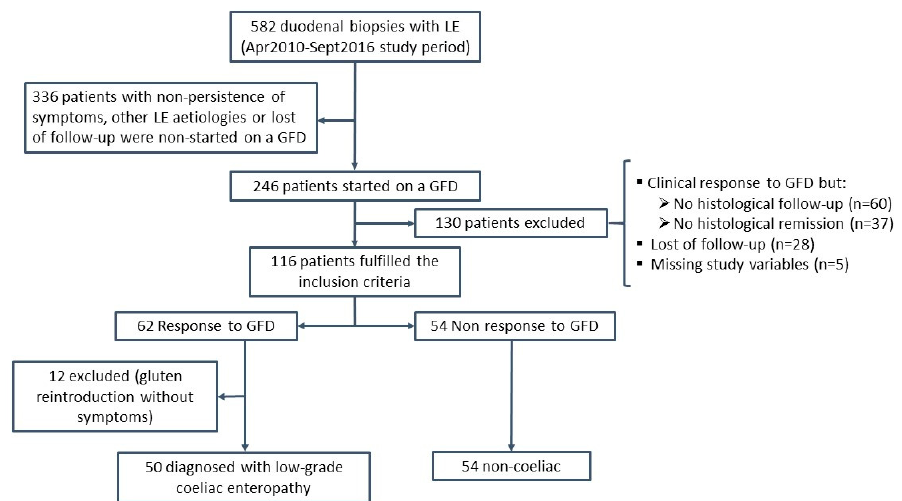
Figure 1. Flow diagram of the participants throughout the study. LE: lymphocytic enteritis (IEL count > 19%); GFD: gluten-free diet.